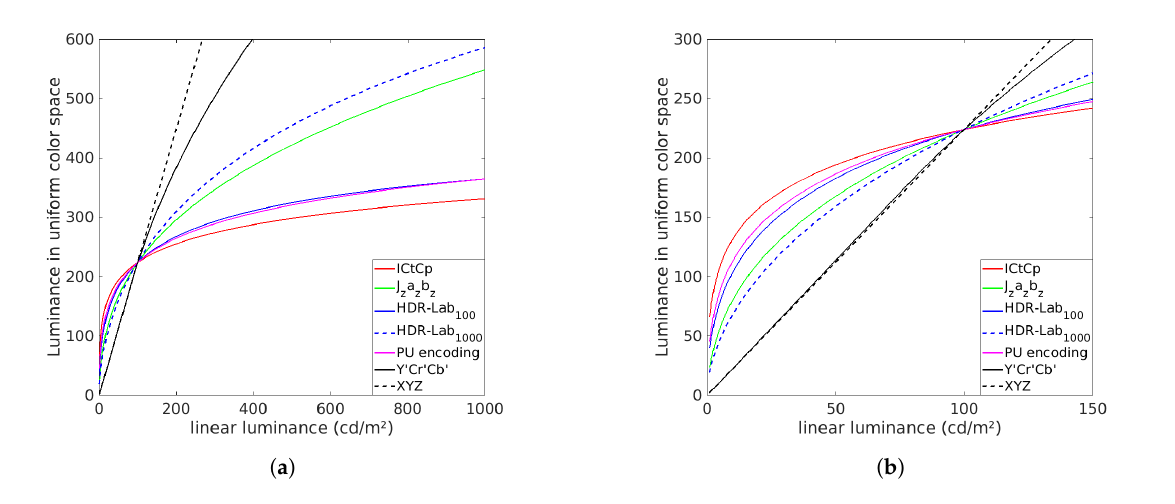
Figure 2. Different perceptually uniform luminances as a function of the linear luminance: ( a ) for the range 0–1000 cd/m 2 , ( b ) for the range 0–150 cd/m 2